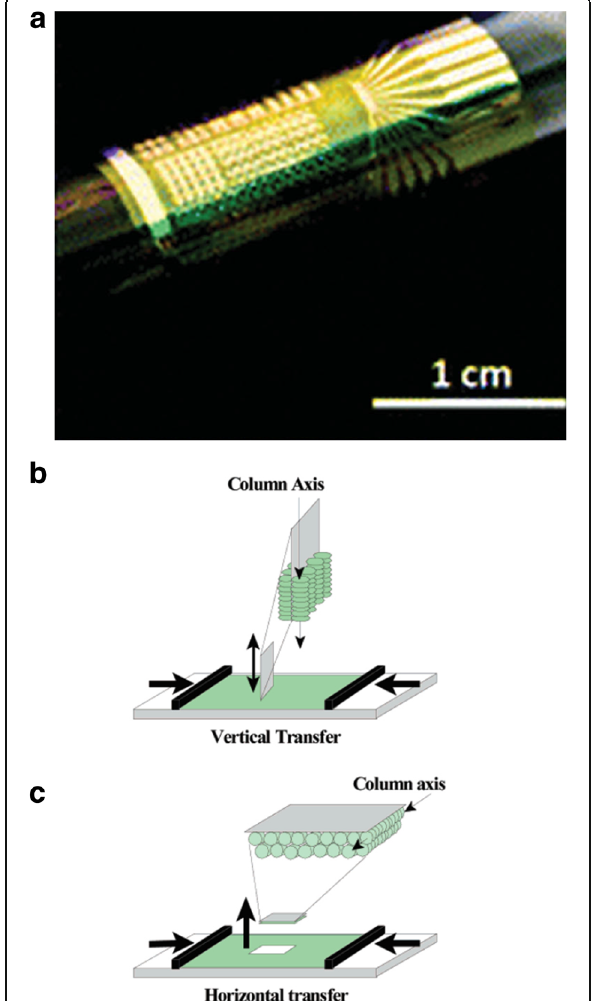
Fig. 42 a Optical image of a CNT-based circuit on polyimide wrapped around a test tube. The circuit was fabricated using CNT inkjet printing. Adapted from [281]. b Schematic of the Langmuir- Blodgett (LB) process for the fabrication of films. The LB process is either performed using the b vertical dipping method or c horizontal lifting method. Adapted from